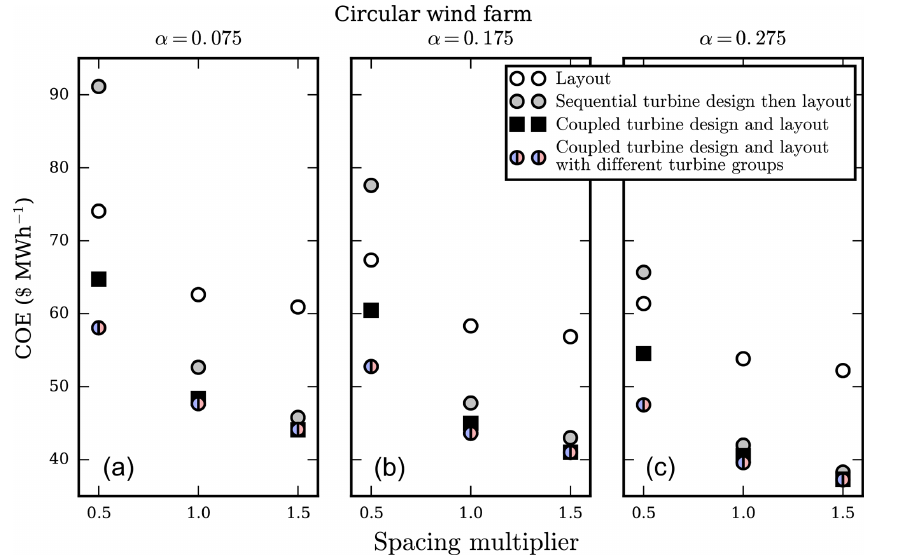
Figure 9. The optimal COE results for the circular wind farm layout with 32 turbines. Each of the subfigures corresponds to optimization runs with a different shear exponent, α = 0 . 075, 0 . 175, and 0 . 275. Within each subfigure, the x axis shows the size of the wind farm based on the spacing multiplier β = 0 . 5, 1 . 0, and 1 . 5. The different points represent the layout optimization with the baseline turbine design, sequential optimization of turbine design and then layout, coupled-layout-and-turbine-design optimization with homogeneous turbine design throughout the farm, and layout-and-turbine-design optimization with two different turbine design